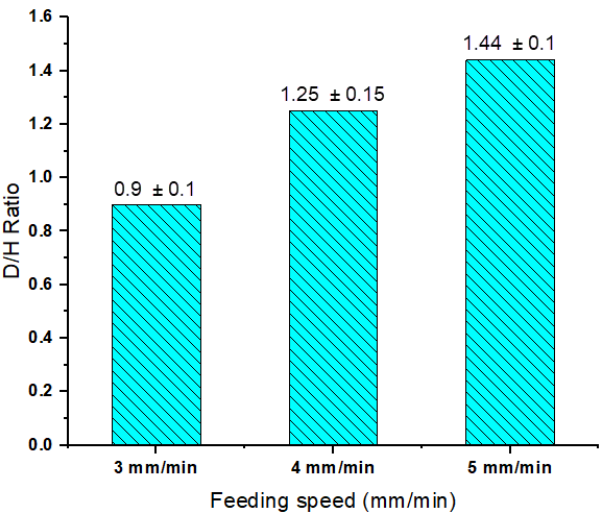
Figure 6 . Diameter/height ratio of AMPs as a function of feeding speed after production at a constant rotation rate of 1200 rpm.